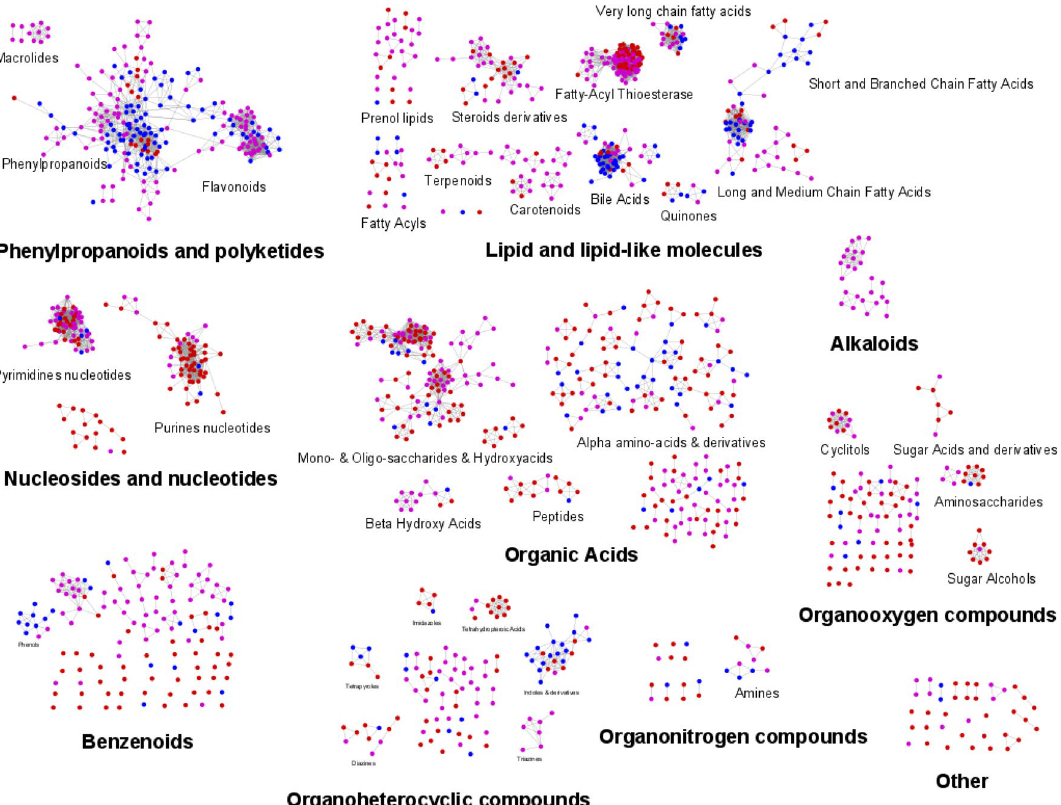
Figure 5. Chemical similarity networks of the 2325 predicted gut microbial metabolites and 457 microbial metabolites in the Exposome-Explorer database. Red nodes from MAMBO genome-scale metabolic model; pink nodes from AGORA genome-scale metabolic model; blue nodes from